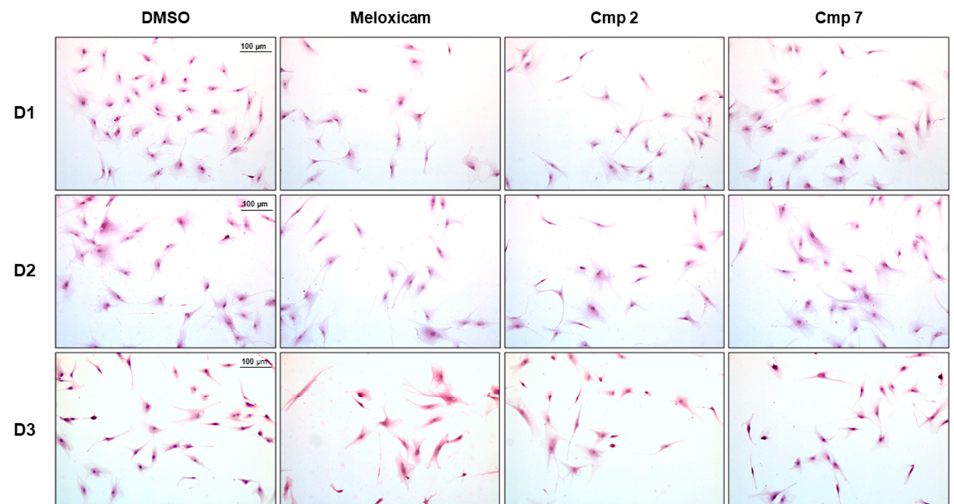
Figure 4. Hematoxylin/eosin (H&E) staining of tendon-derived cells pre-incubated with hydrogen peroxide (H 2 O 2 ) in the presence of Meloxicam and Cmp 2 and Cmp 7 . Light microscopy images show tenocytes isolated from the three donors (D1 = donor 1; D2 = donor 2; D3 = donor 3), pre-incubated with H 2 O 2 100 µM for 3 h and afterwards exposed to Meloxicam, Cmp 2 , and Cmp 7 50 µM for 24 h, stained with H&E. Magnification 100×. Bar scale represents 1 cm = 100 µm. As for cell cycle analysis (Figure 5), profiles of tenocytes in the presence of Meloxicam and CAI-CORM hybrids were compared to T0, which represents proliferating cells from routine culture, and tenocytes pre-incubated with H 2 O 2 in the presence of DMSO alone (Figure 5A,B). As expected, tenocytes in the DMSO control display an increased G2 phase compared to the one of T0 (16.9% and 8.44%, respectively). It is well known indeed that in response to overuse or inflammation, tenocytes increase their metabolic activity and multiply [6,27]. In the presence of Meloxicam, percentages of cells in the various phases of cell cycle are comparable to the ones of the DMSO control. When Cmp 2 is present, a dose-dependent increase in terms of cell percentage in the G2 phase is registered, being doubled with respect to DMSO alone at 50 µM (32.9%). As well, tenocytes in the G2 phase after the administration of Cmp 7 are increased already at 25 µM (24.2%) with respect to Cmp 2 at the same concentration (21.7%). Cells presumably undergoing mitosis in the presence of Cmp 7 at 25 µM are observed also microscopically, as shown in Figure 5C by red arrows.